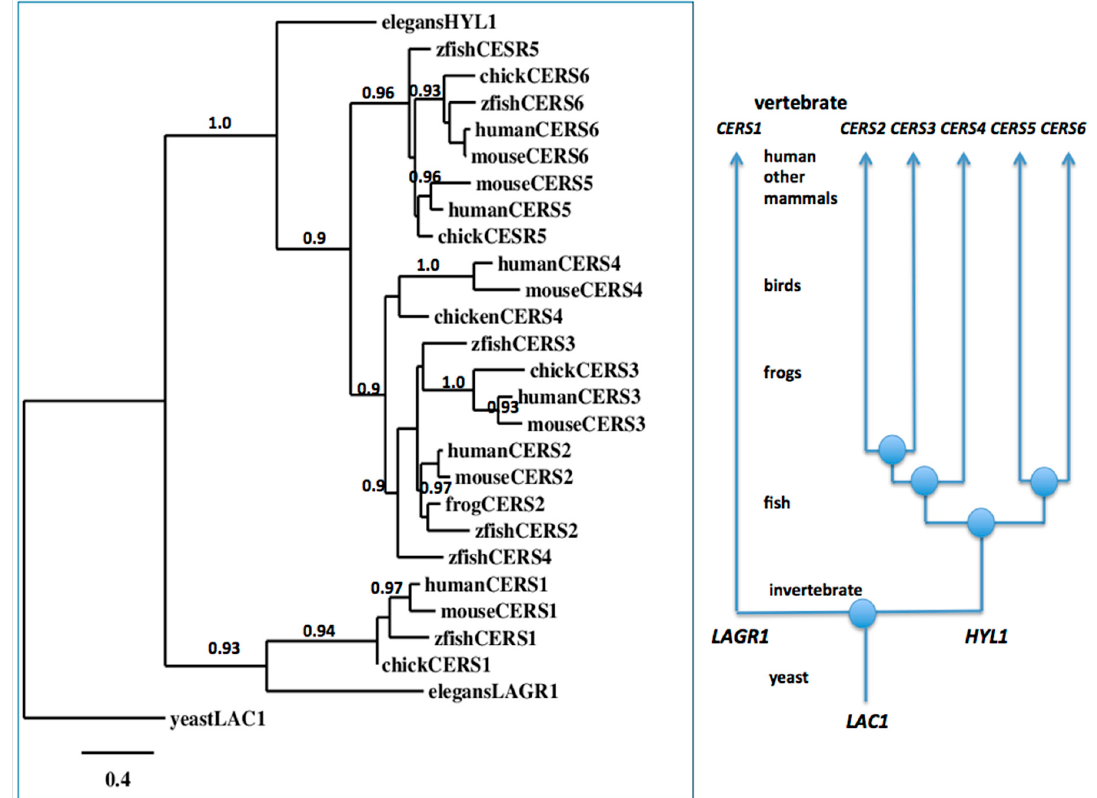
Figure 6. Phylogenetic tree of vertebrate CerS1-6 amino acid sequences and nematode LAGR1 and HYL1 sequences rooted with the yeast Lac1 sequence. The tree is labelled with the ceramide synthase names and the names of the animal or organism and is rooted with the yeast ( Saccharomyces cerevisiae) LAC1 sequence. See Tables 1 and 2 for details. Note the clusters corresponding to the CerS1–6 gene families. A genetic distance scale is shown. The number of times a clade (sequences common to a node or branch) occurred in the bootstrap replicates are shown. Replicate values of 0.9 or more, which are highly significant, are shown with 100 bootstrap replicates performed in each case. A proposed sequence of gene evolution events is shown arising from ancestral yeast LAC1 and invertebrate LAGR1 and HYL1 genes.